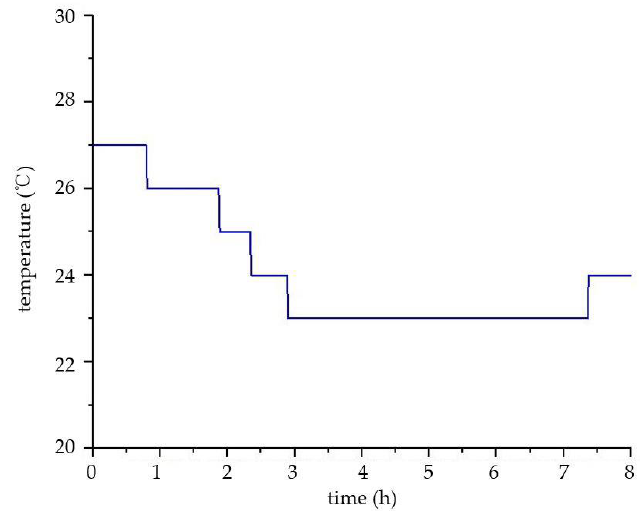
Figure 19. The curve of temperature.